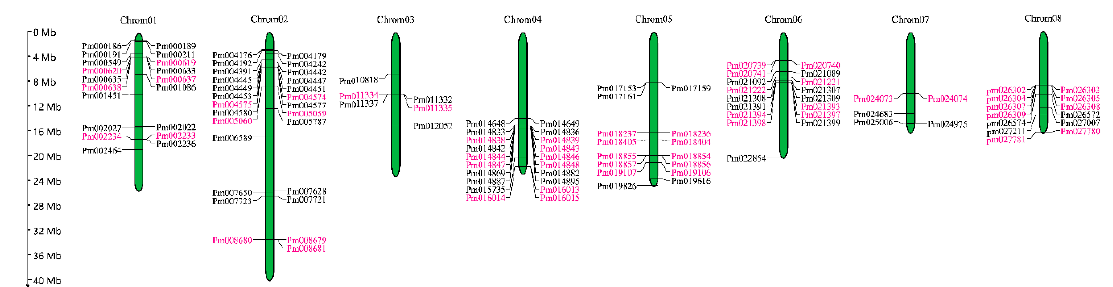
Figure 1. Chromosomal locations of PmUGT genes. The left scale represents the megabases (Mb). Chromosome numbers are shown at the top of each vertical green bar. The rough location of each maize PmUGTs is marked with the grey line. The tandem duplication gene pairs are highlighted with red.